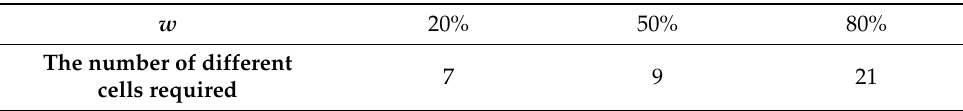
Table 5. The number of cells corresponding to different w